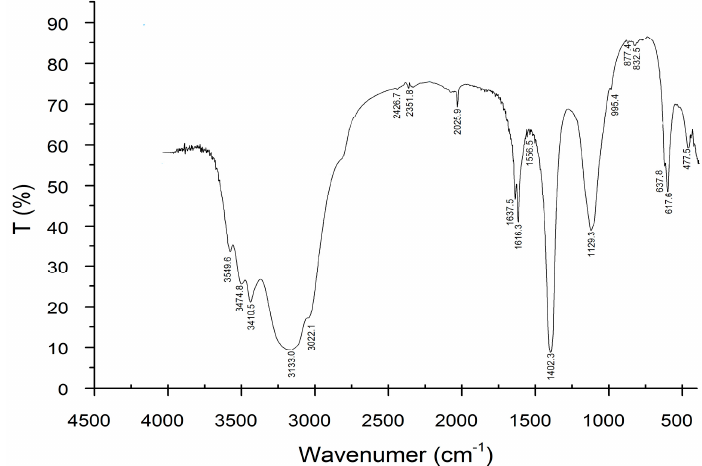
Figure 4. Fourier-transform infrared ( FT-IR) spectrum of M2.